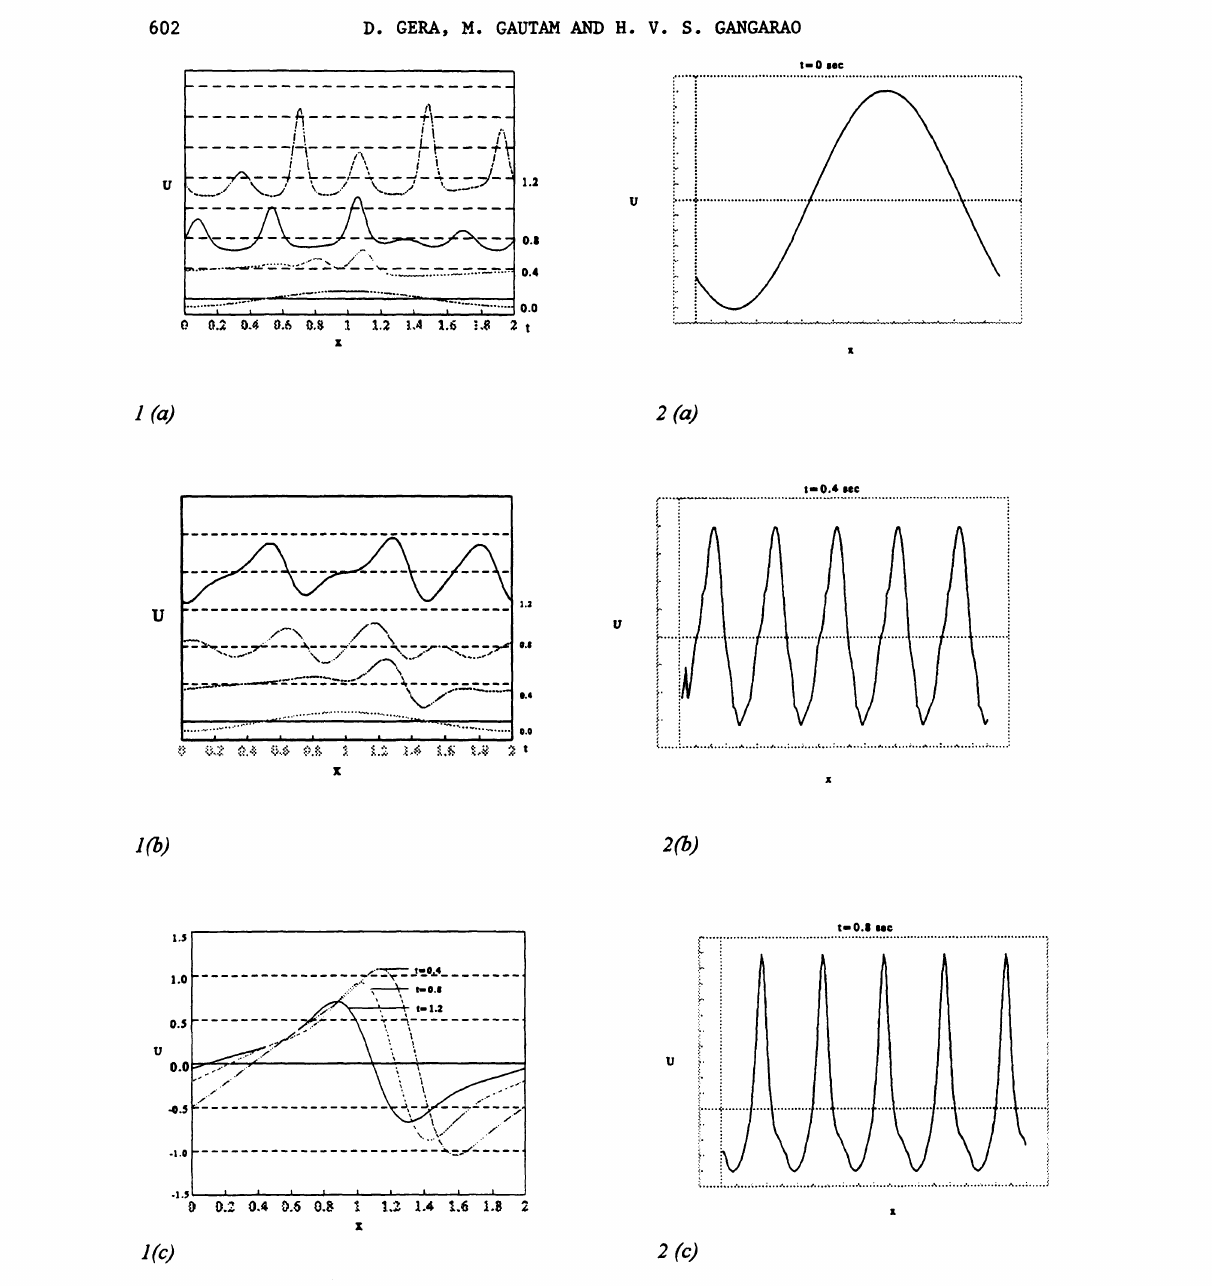
Figure 2 Temporal evolution of U for initial condition -cos(rrx)-sin(rrx) at (a) t--.0 see, (b) t---0.4 see (C) w0.8